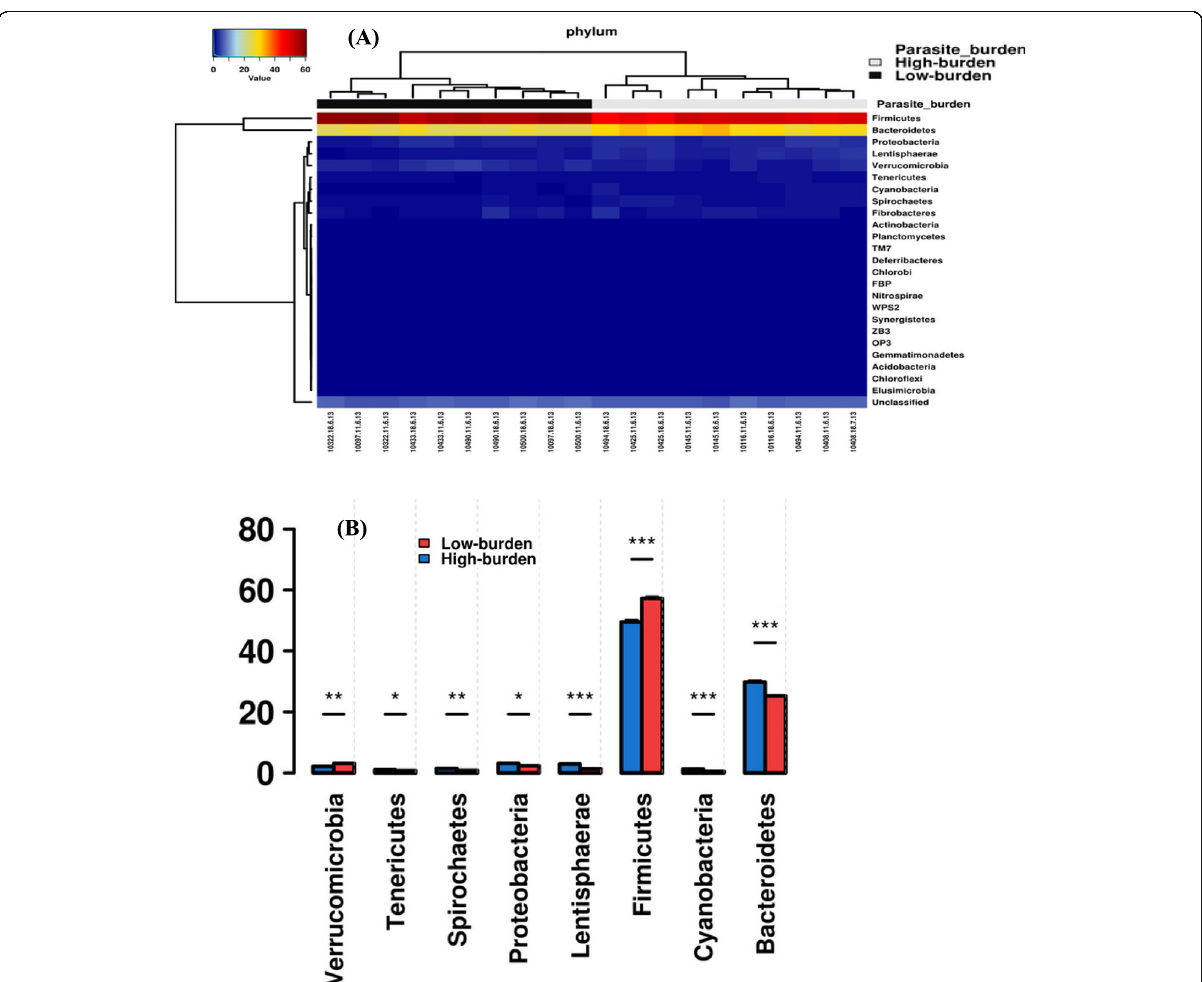
Fig. 3 Average relative abundances (%) of identified phyla. ( a ) HeatMap+ of the relative abundances of the identified phyla; ( b ) the phyla with a significant difference in relative abundances in high and low burden sheep. The Y-axis shows the average relative abundances (%); X-axis shows phyla. Unpaired t-test. Error bars represent SD. * p ≤ 0.05, ** p ≤ 0.01, *** p ≤